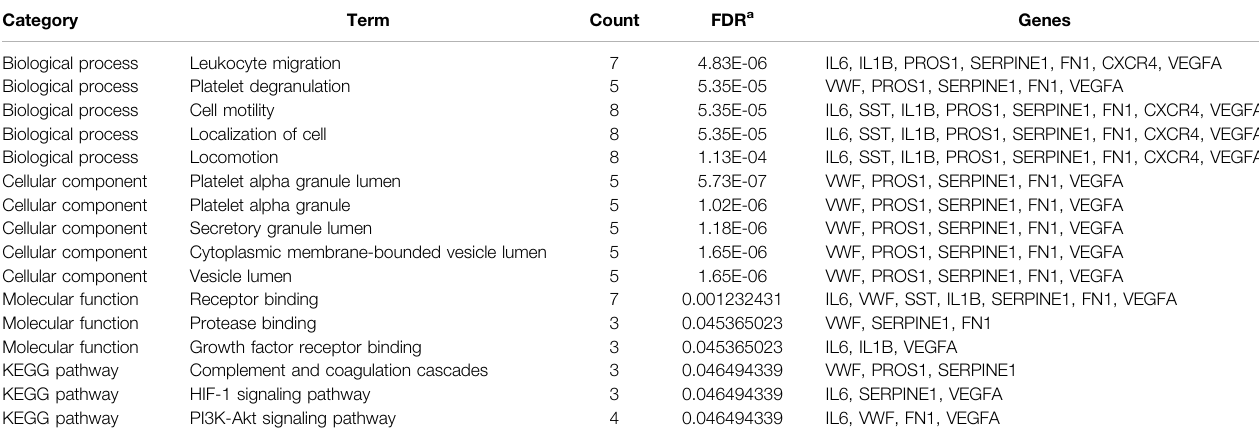
TABLE 2 | Summary of gene set enrichment analysis.